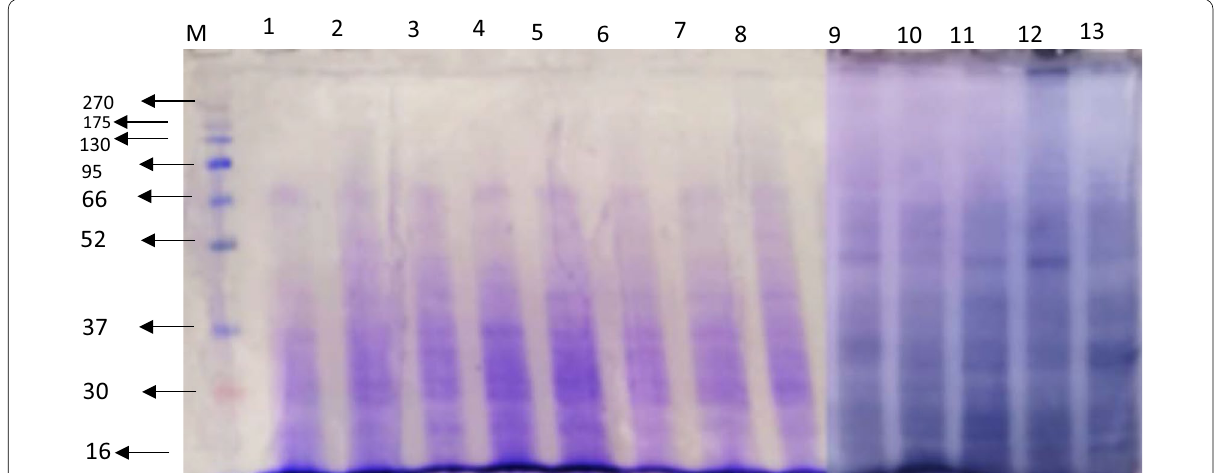
Fig. 1 Protein banding patterns in 13 rice genotypes under normal conditions. Lane 1 14 the highest five hybrids, respectively =